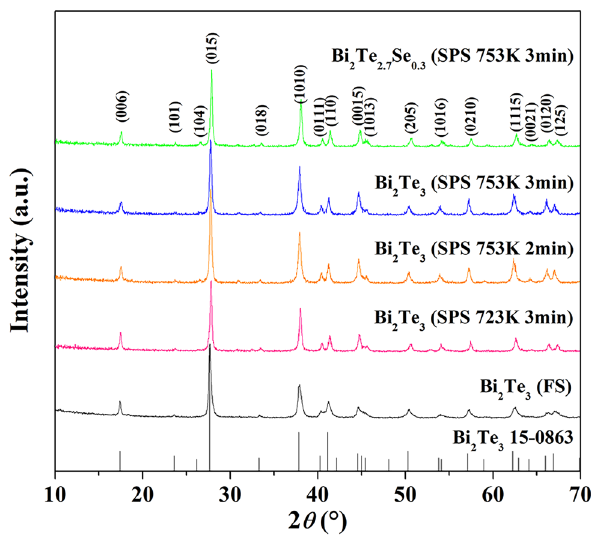
Figure 2. XRD patterns of the Bi 2 Te 3 compound synthesized by FS and the Bi 2 Te 3−x Se x bulk samples further prepared by SPS on different conditions.